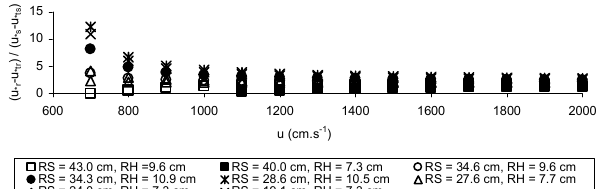
(lower) than 1 indicates greater (lower) horizontal flux over the ridged surface and thus the roughness leads to an increase (decrease) in soil